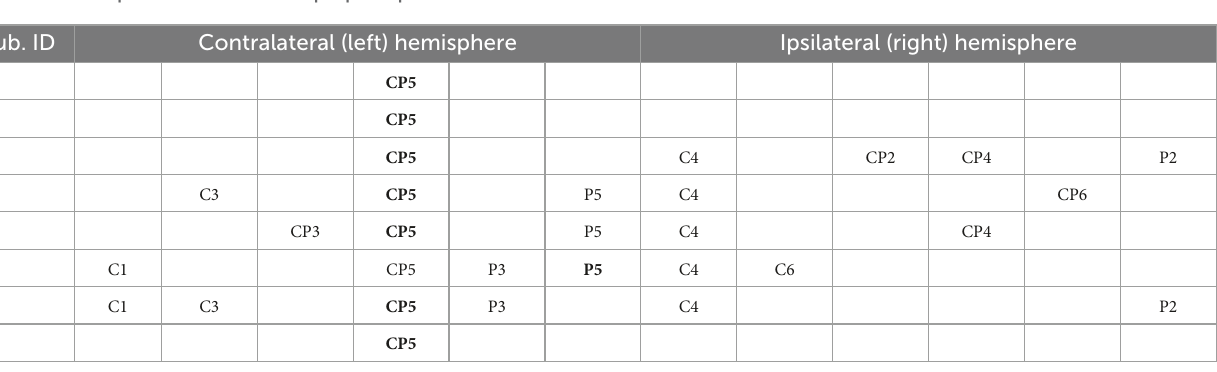
TABLE 1 Most representative electrodes per